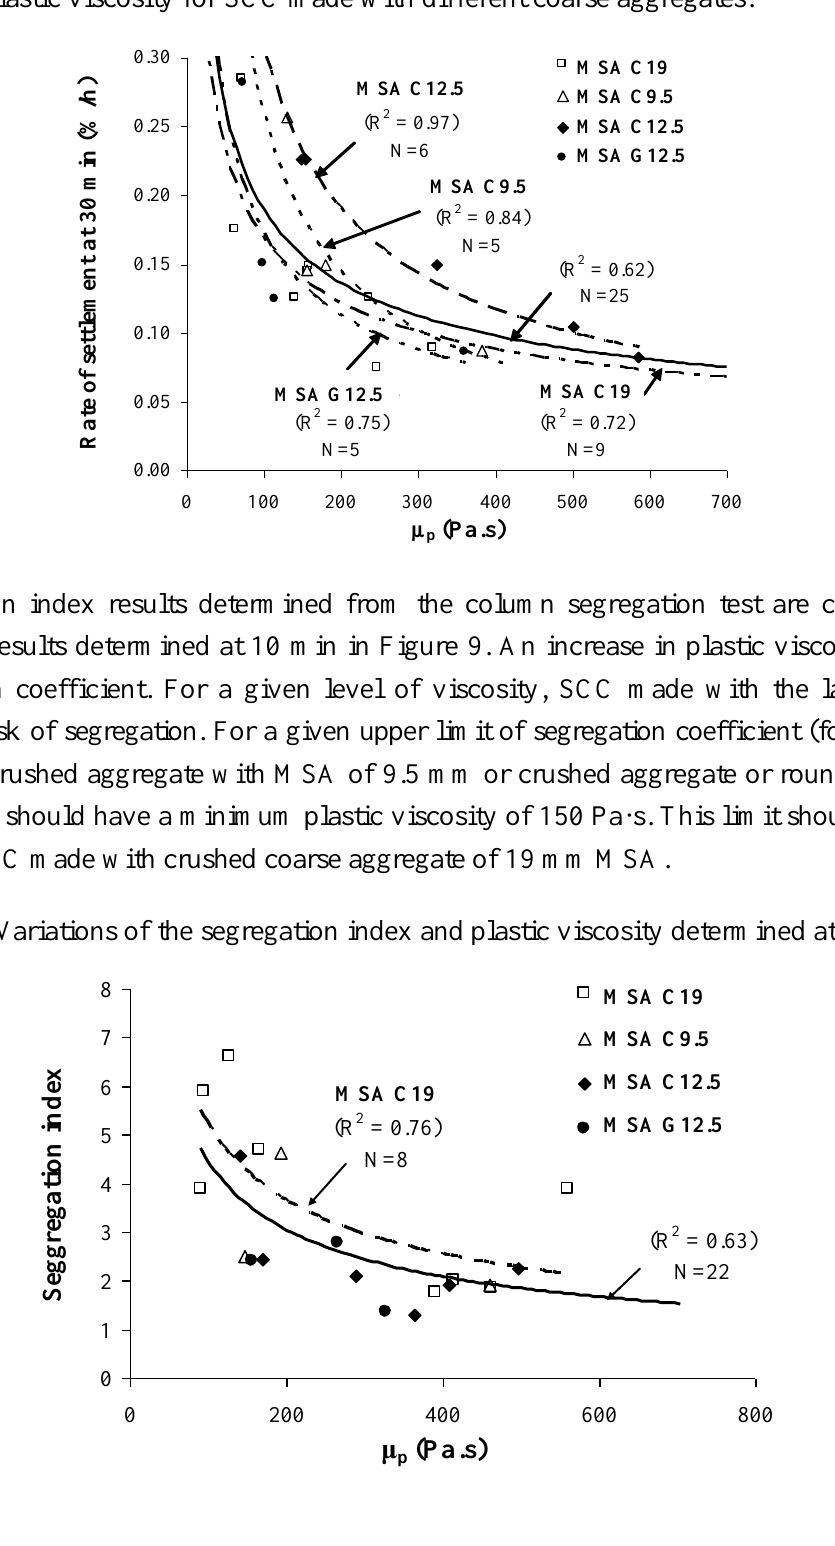
Figure 8. Variations of the rate of surface settlement determined after 30 min of testing and initial plastic viscosity for SCC made with different coarse aggregates.